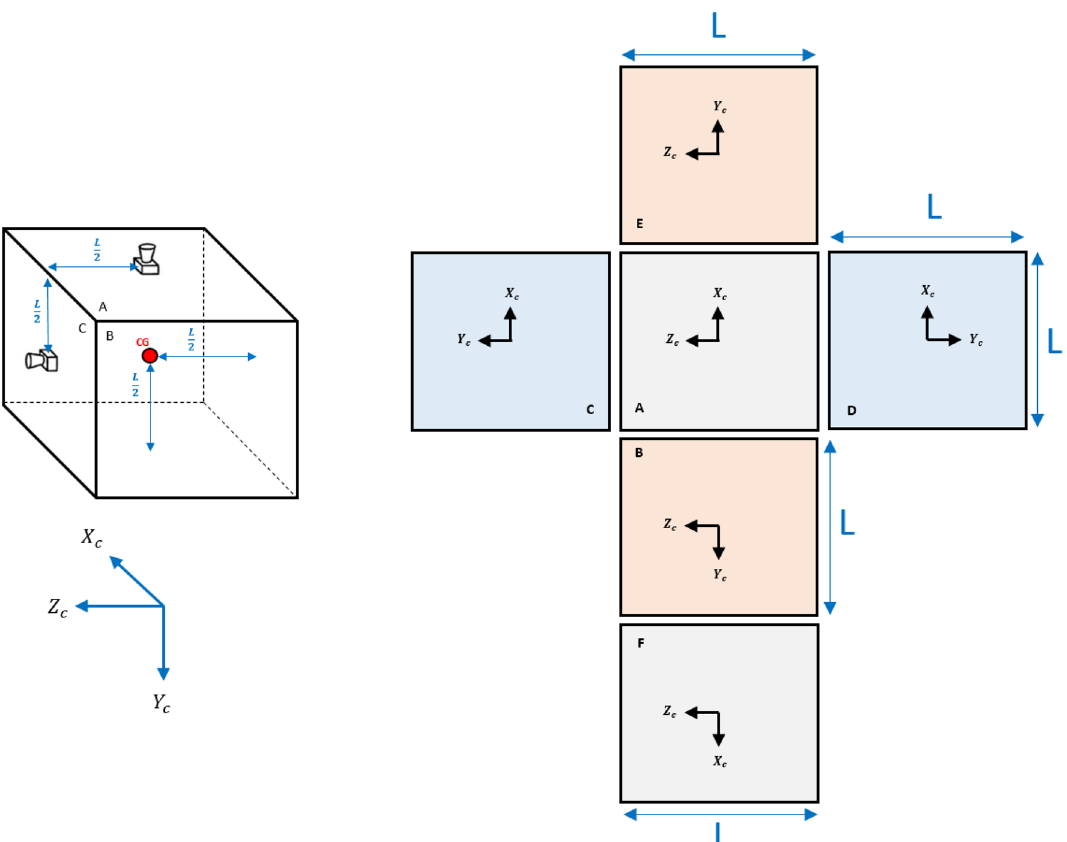
Figure 12. Thrusters arm from